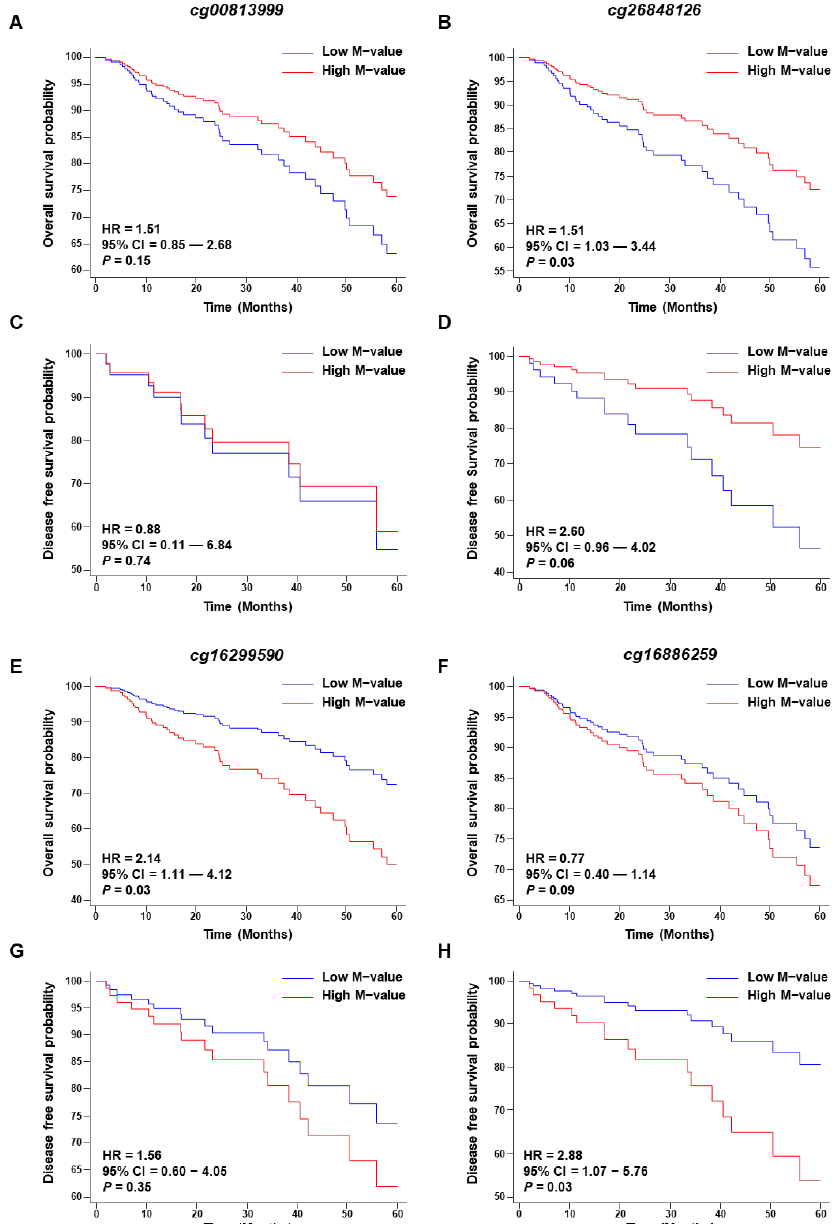
Figure 5. Kaplan–Meier plot for the CpG probes. Five-year overall and disease-free survival plots for CpG probes cg00813999 ( A , C ) and cg26848126 ( B , D ) for the CYSLTR1 gene. Five-year overall and disease-free survival plots for CpG probes cg16299590 ( E , G ) and cg16886259 ( F , H ) for the CYSLTR2 gene.